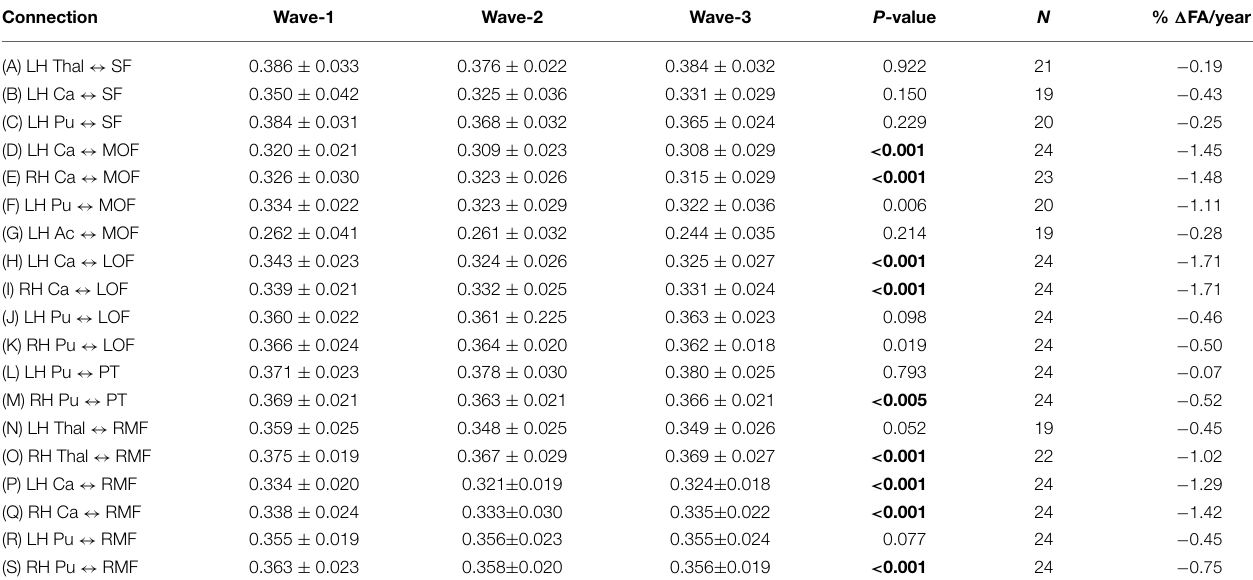
TABLE 5 | Mean and standard deviation of tract mean FA in the 19 extracted fiber connections (A)–(S) (column 1) that were detected in the subsample of 24 participants having three MRI examinations: at baseline (column 2), at first follow-up (column 3) and at second follow-up (column 4). Connection